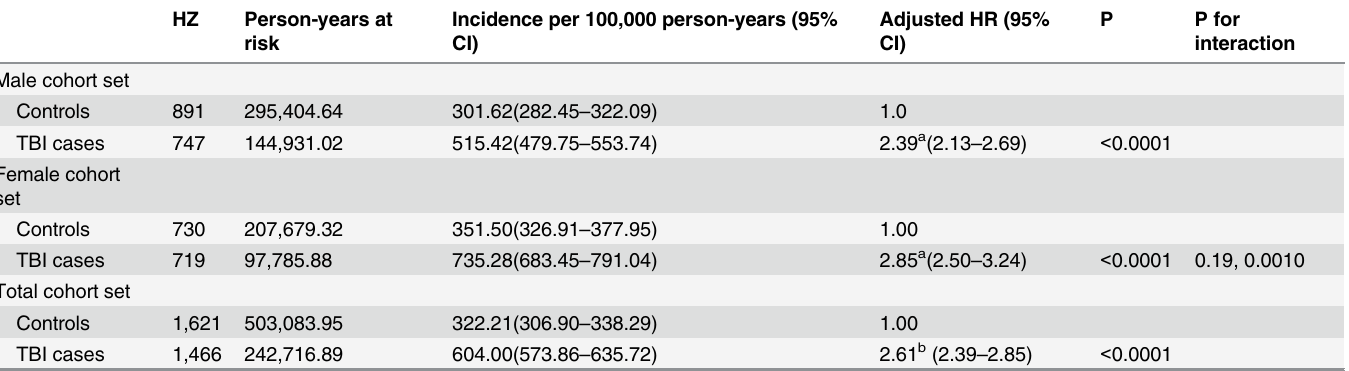
Table 2. Incidence and hazard ratios for herpes zoster during the follow-up period for adult patients with traumatic brain injury versus control